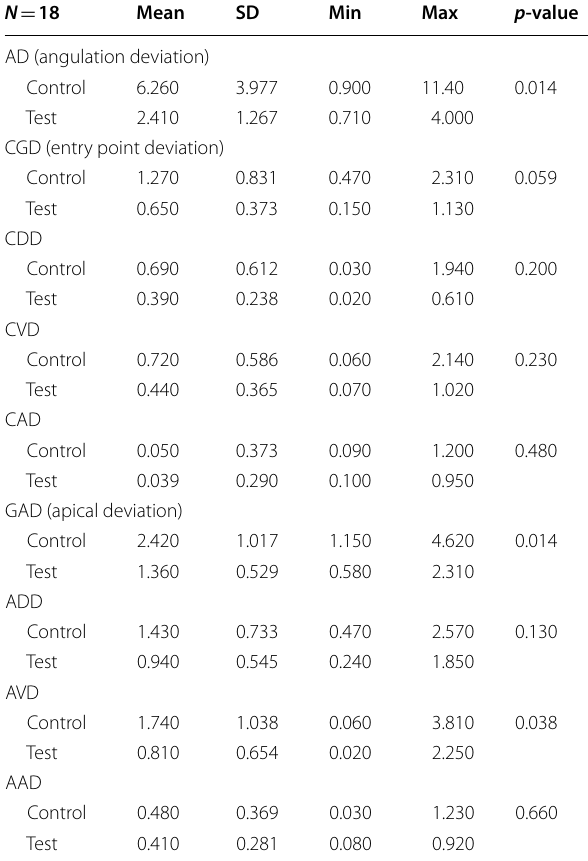
Table 2 Deviation of implant position in static CAIS and free- handed implant surgery